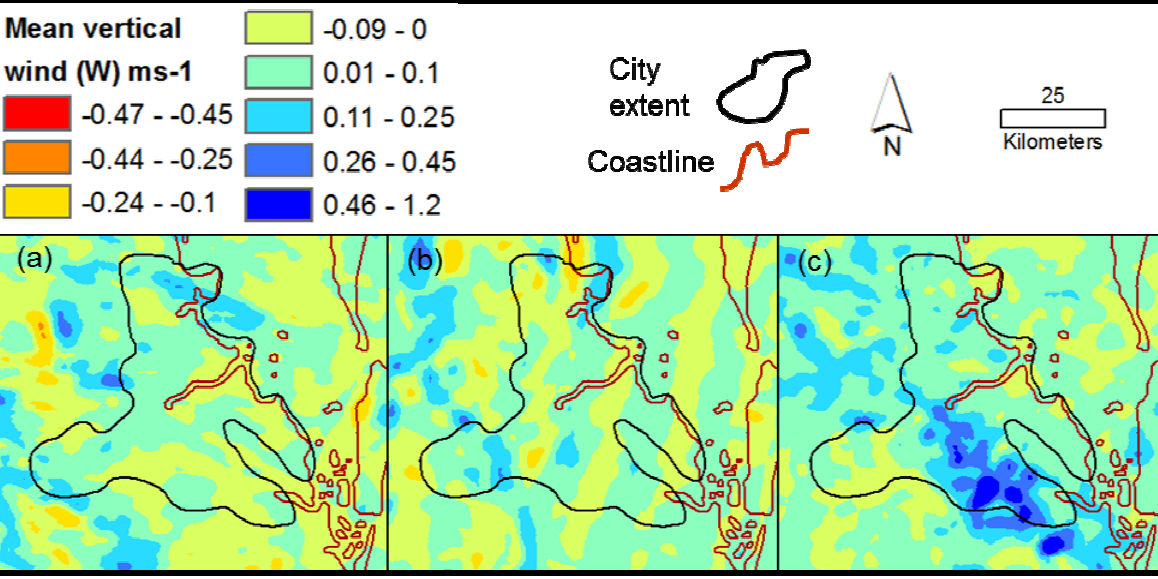
Figure 10. WRF mean below tropopause vertical wind speed for three rain events: ( a ) Sc2009, ( b ) Cu/Sc2010 and ( c ) St2011.